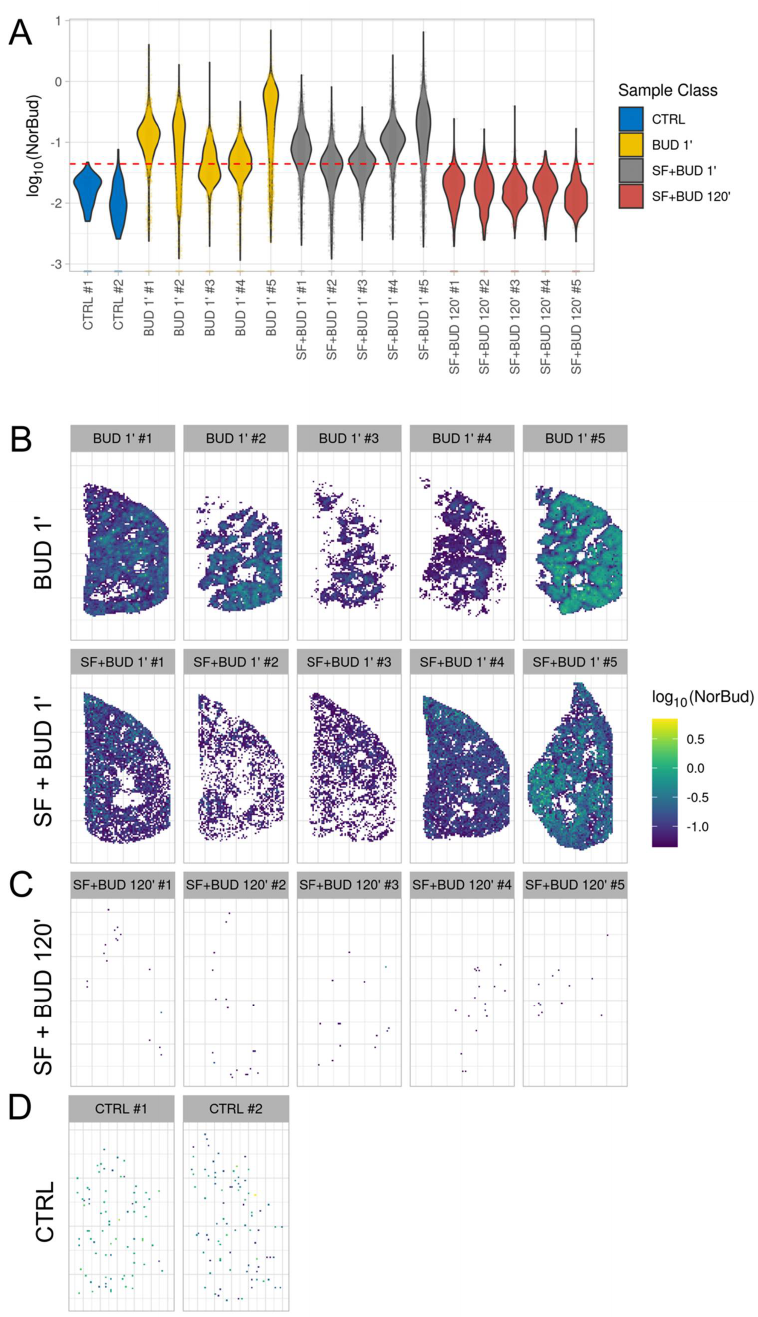
Figure 2. Analysis of budesonide lung distribution by MSI. ( A ) Violin plots displaying the logarithm of the intensity of each animal included in the study. The dashed red line represents the signal density threshold for budesonide, which was set by taking the control animals (never received budesonide) as a reference. ( B ) 2D ion intensity images displaying the distal budesonide lung distribution in samples obtained from premature lambs that were ventilated for just 1 min after either receiving intratracheal budesonide (0.25 mg/kg, top row, BUD 1 (cid:48) ) or budesonide (0.25 mg/kg) combined with surfactant (200 mg/kg, bottom row, SF+BUD 1 (cid:48) ). ( C ) 2D ion intensity images displaying the distal budesonide lung distribution in samples obtained from premature lambs that were ventilated for 120 min after receiving budesonide (0.25 mg/kg) combined with surfactant (200 mg/kg, SF+BUD 120 (cid:48) ). ( D ) 2D ion intensity images of untreated control (CTRL) animals, which were used to set the budesonide intensity signal